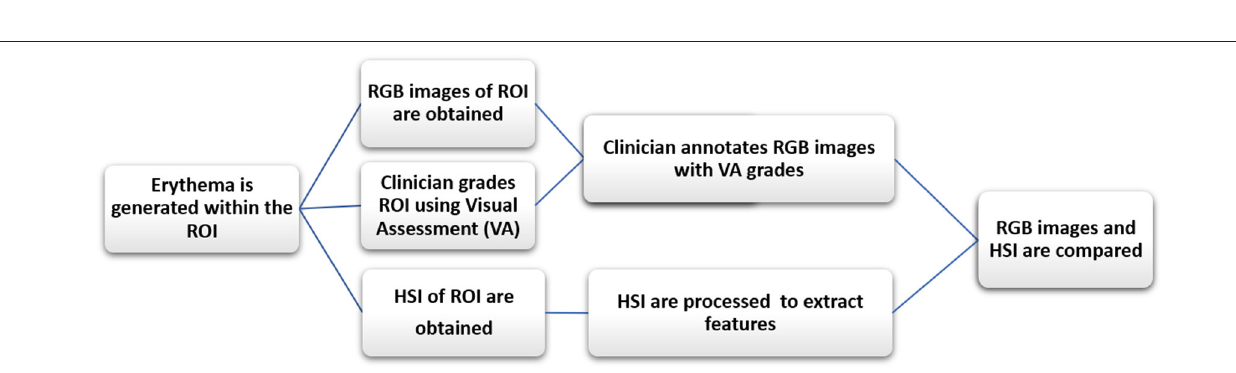
FIGURE 2 | The flow chart illustrates the study’s design. After initiating erythema within the ROI, the skin is graded by VA and RGB and HSI were obtained. The clinician then annotates the RGB images with the erythema scores. After processing the HSI, the annotated RGB images are compared to the HSI ones. The RGB images are used as a proxy to compare HSI to VA.